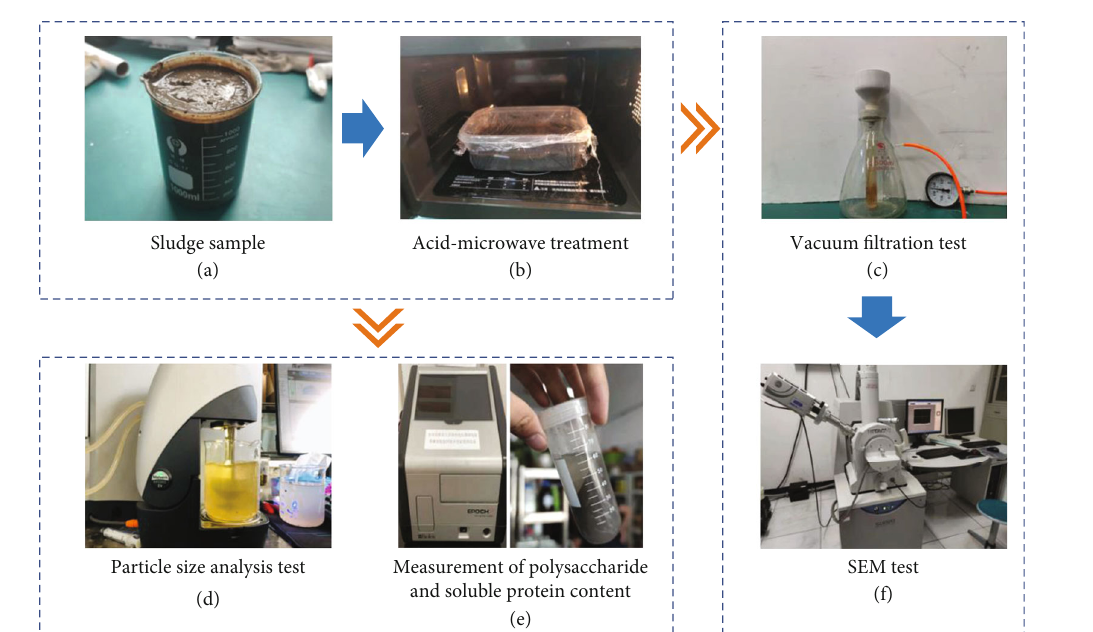
Figure 1: Flow diagram of this study.